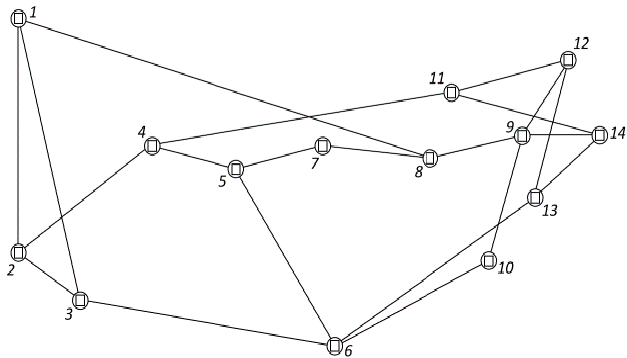
Figure 3. The US NSF network (topologically, not geographically, accurate).